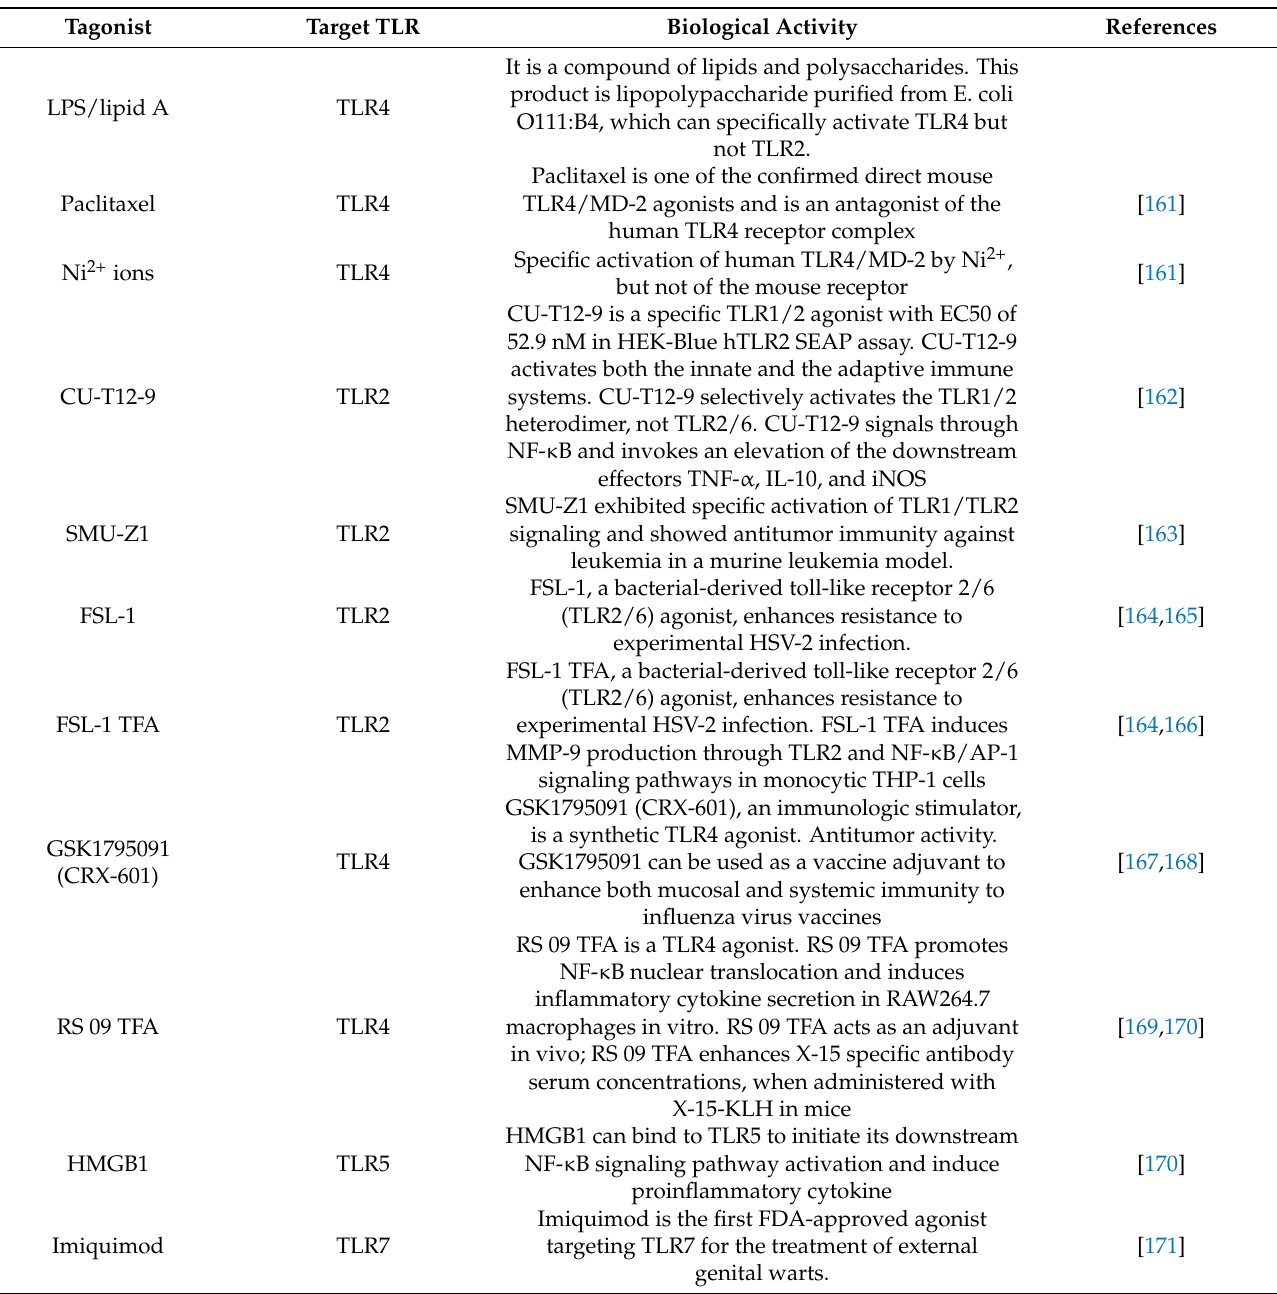
Table 2. Some experimental types of TLR